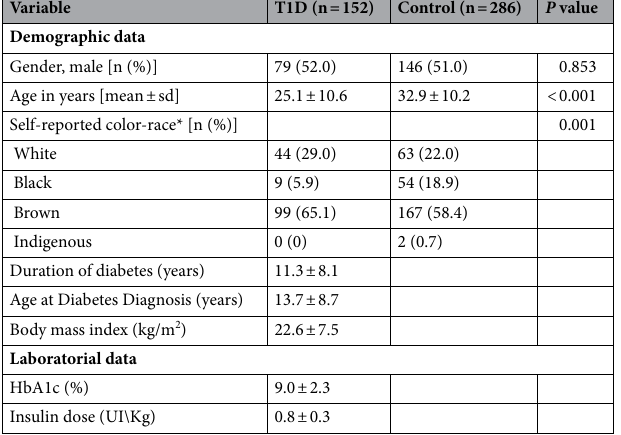
Table 1. Demographic and clinical data of the studied population. Data are presented as number (percentage), mean ± standard deviation. T1D type 1 diabetes, HbA1c hemoglobin